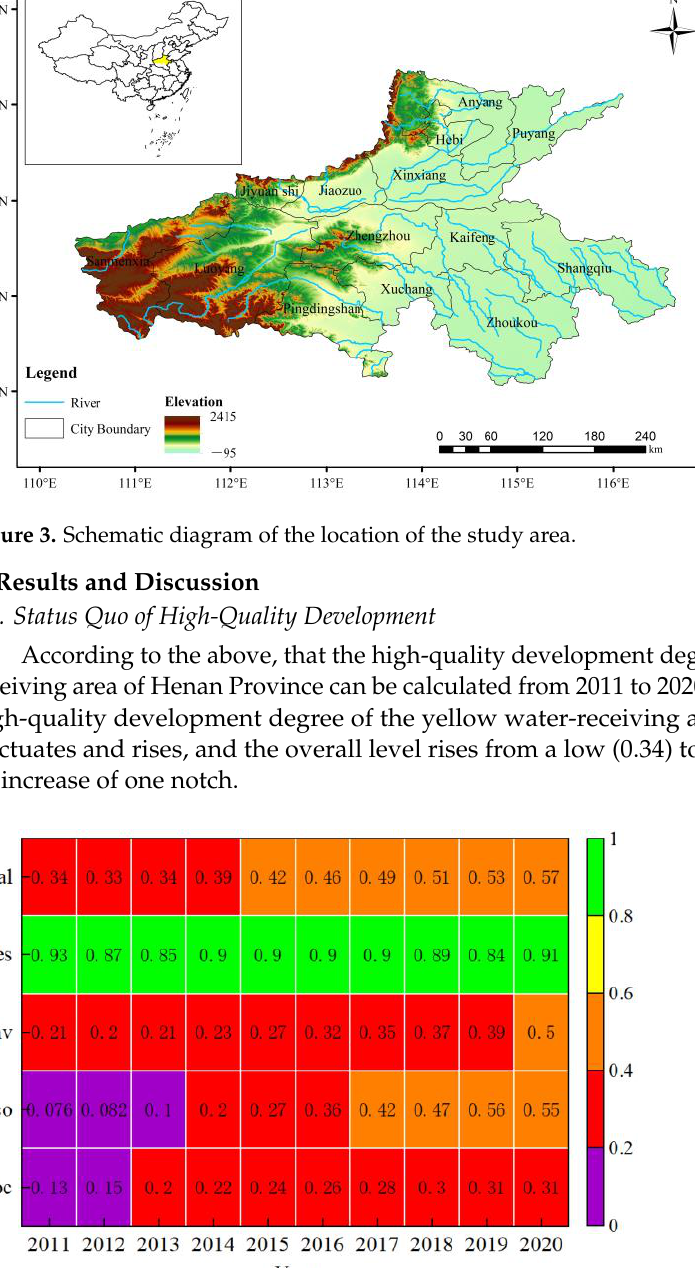
Figure 4. Changes in the degree of high-quality development of regional systems and the whole.